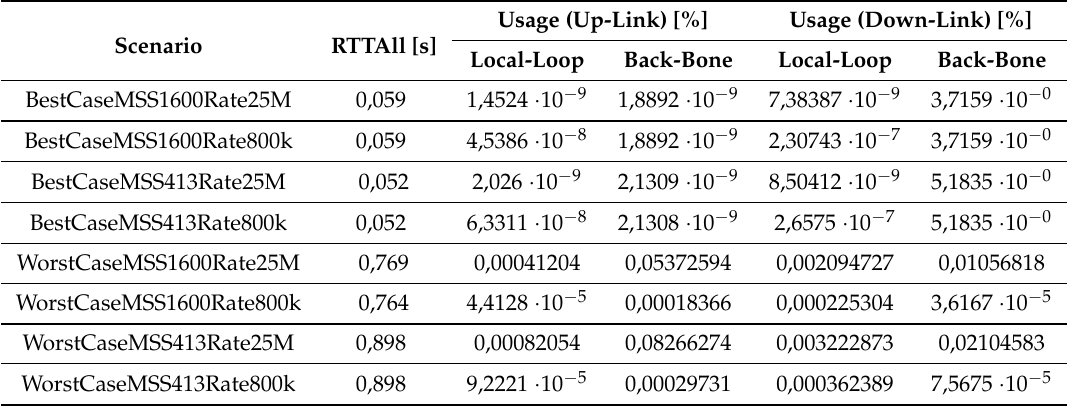
Table A3. Standard deviation of the results for the different scenarios analyzed with GPRS technology (Figures 10 and